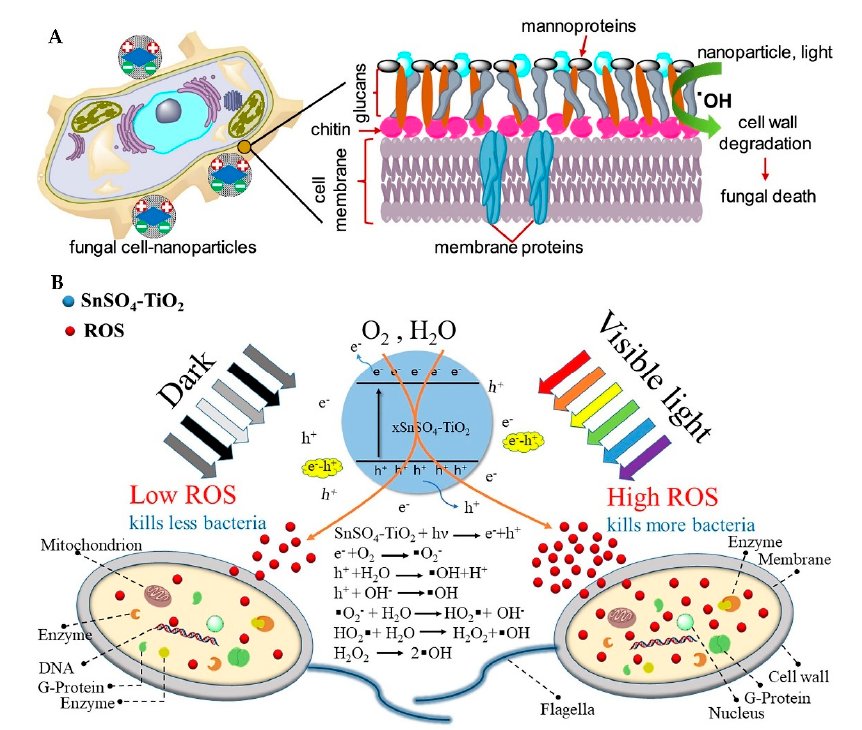
Figure 11. ( A ) Proposed mechanism of the antifungal activity of N, F doped TiO 2 nanoparticles [65]; ( B ) schematic diagram displaying the antibacterial mechanism of SnSO 4 -TiO 2 [88].